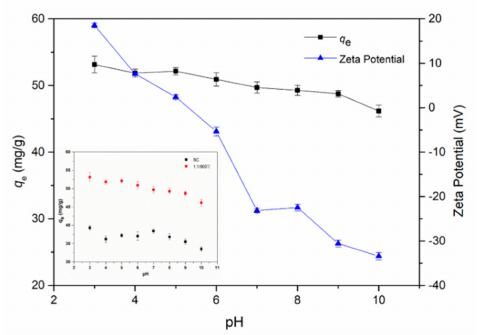
Figure 6. E ff ect of initial solution pH on E2